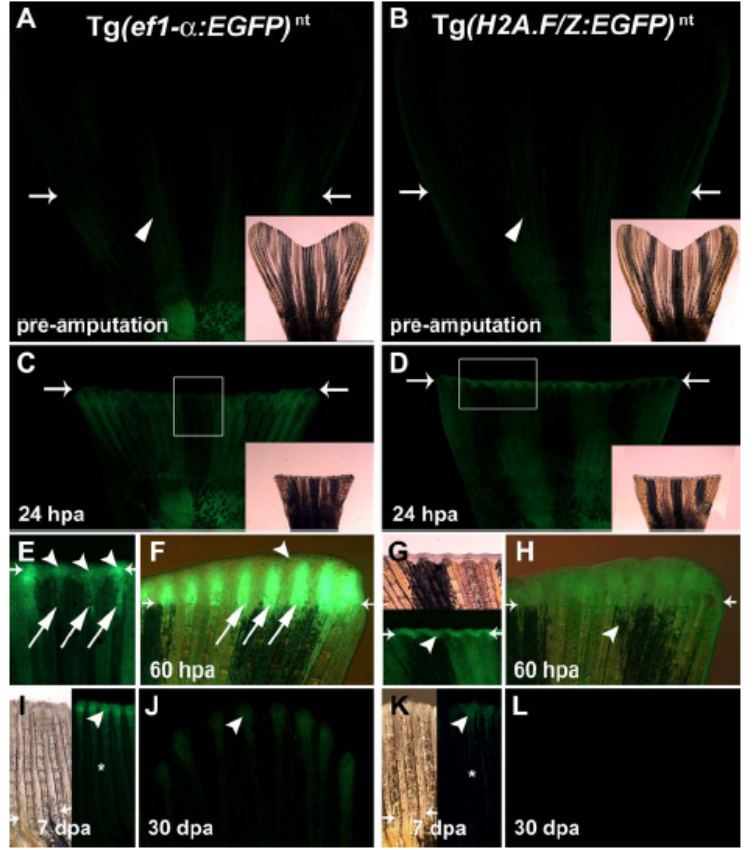
FIGURE 4. Differential expression of Tg (ef1-a:EGFP) nt and Tg (H2A.F/Z:EGFP) nt during caudal fin regeneration. Panels on the left (A, C, E, F, I, J) represent Tg (ef1-a:EGFP) nt fins, while panels on the right (B, D, G, H, K, L) represent Tg (H2A.F/Z:EGFP) nt fins. Wholemount fluorescent images reveal very low levels of EGFP expression in both the Tg (ef1-a:EGFP) nt and Tg (H2A.F/Z:EGFP) nt fins (panels A and B, respectively). A single white arrowhead denotes very weak EGFP expression, which can only be observed at high magnification in nonpigmented areas of the proximal fin, which is not observed distally. Two white arrows flanking the fin denote the plane of amputation used for the regeneration studies shown in the following panels. A brightfield image of both fins is shown in the inset. (C,D) Fluorescent images of the transgenic fins shown in panels A and B at 24 hpa (with brightfield images inset). Both transgenic fins reveal an up-regulation of EGFP expression. (E) Close-up of the boxed region outlined in panel C, revealing expression of the ef1-a:EGFP transgene in the presumptive blastemas (arrowheads) and in a few cells (large arrows) proximal to the amputation plane (small arrows). (F) A merged fluorescence/brightfield image at 60 hpa shows intense EGFP expression in the blastemas and trailing to the amputation plane (small arrows). Note the absence of EGFP expression in the wound epithelium (arrowhead). (G) Brightfield and fluorescent images of the boxed region in panel D, reveals EGFP expression from the H2A.F/Z:EGFP transgene at 24 hpa. Note the diffuse EGFP expression throughout the newly formed tissue (arrowhead). (H) A merged fluorescence/brightfield image at 60 hpa shows diffuse EGFP expression from the H2A.F/Z:EGFP transgene throughout the newly formed tissue. (I) Brightfield and fluorescence images at 7 dpa demonstrate that EGFP expression is restricted to the distal-most mesenchyme (arrowhead), but is no longer present in the differentiated regenerated fin tissue (asterisk). (J) Fluorescent image at 30 dpa shows persistent low-level expression at the distal-most fin. (K) Brightfield and fluorescence images at 7 dpa demonstrate that EGFP expression is now restricted to the tissue at the distal-most aspect of the fin (arrowhead), but is no longer present in the differentiated regenerated fin tissue (asterisk). (L) Fluorescent image at 30 dpa shows the absence of